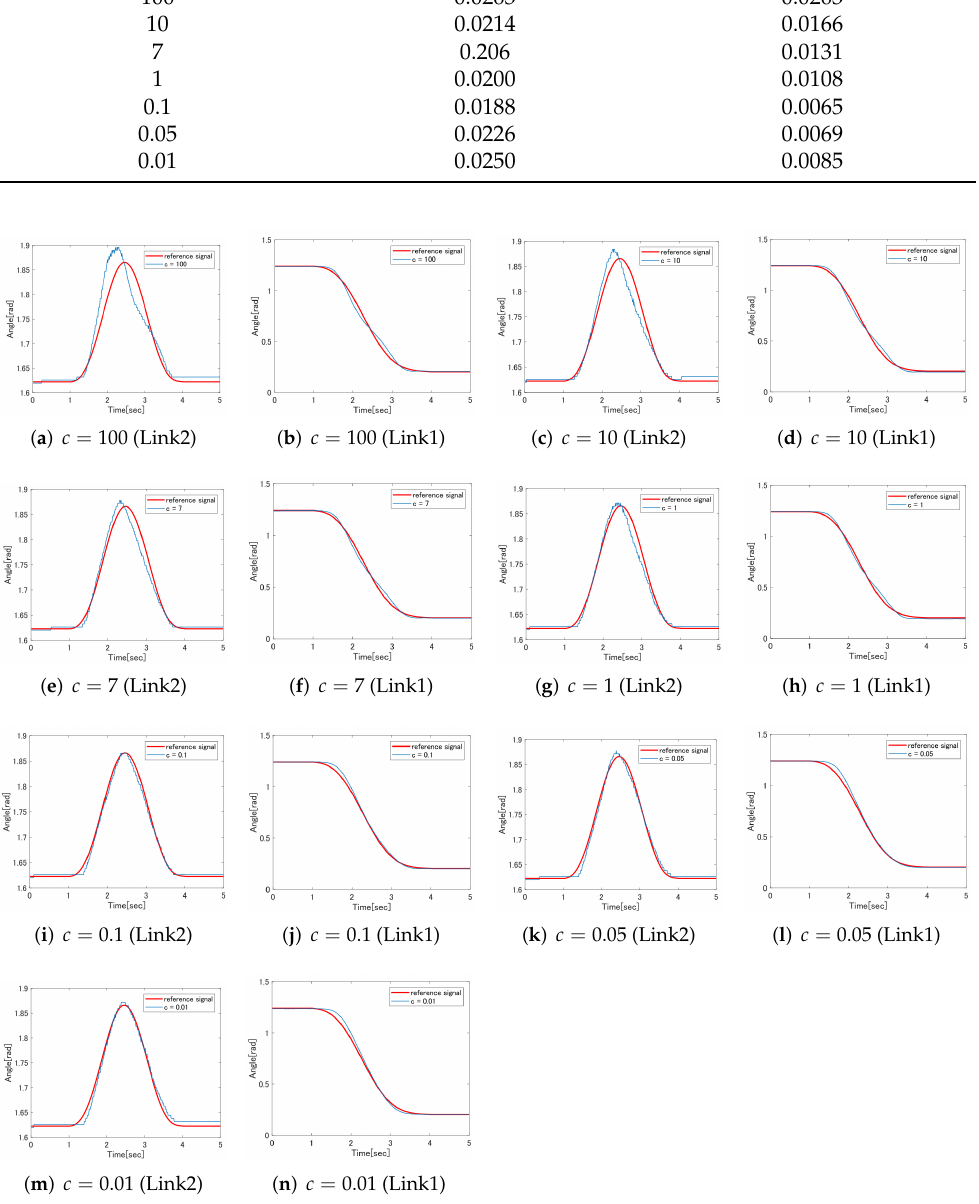
Figure 10. The experimental